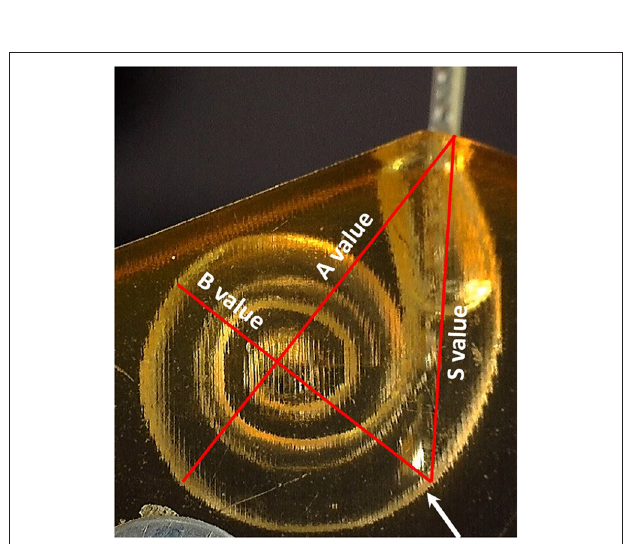
FIGURE 5 | The point where the electrode tip touches the inner wall of the cochlear model corresponds to the end of the S-value as pointed by the white